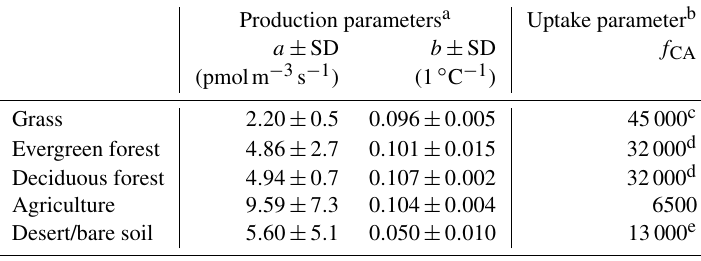
Table 2. Biome-averaged uptake and production parameters after Meredith et al. (2018, 2019). Production parameters